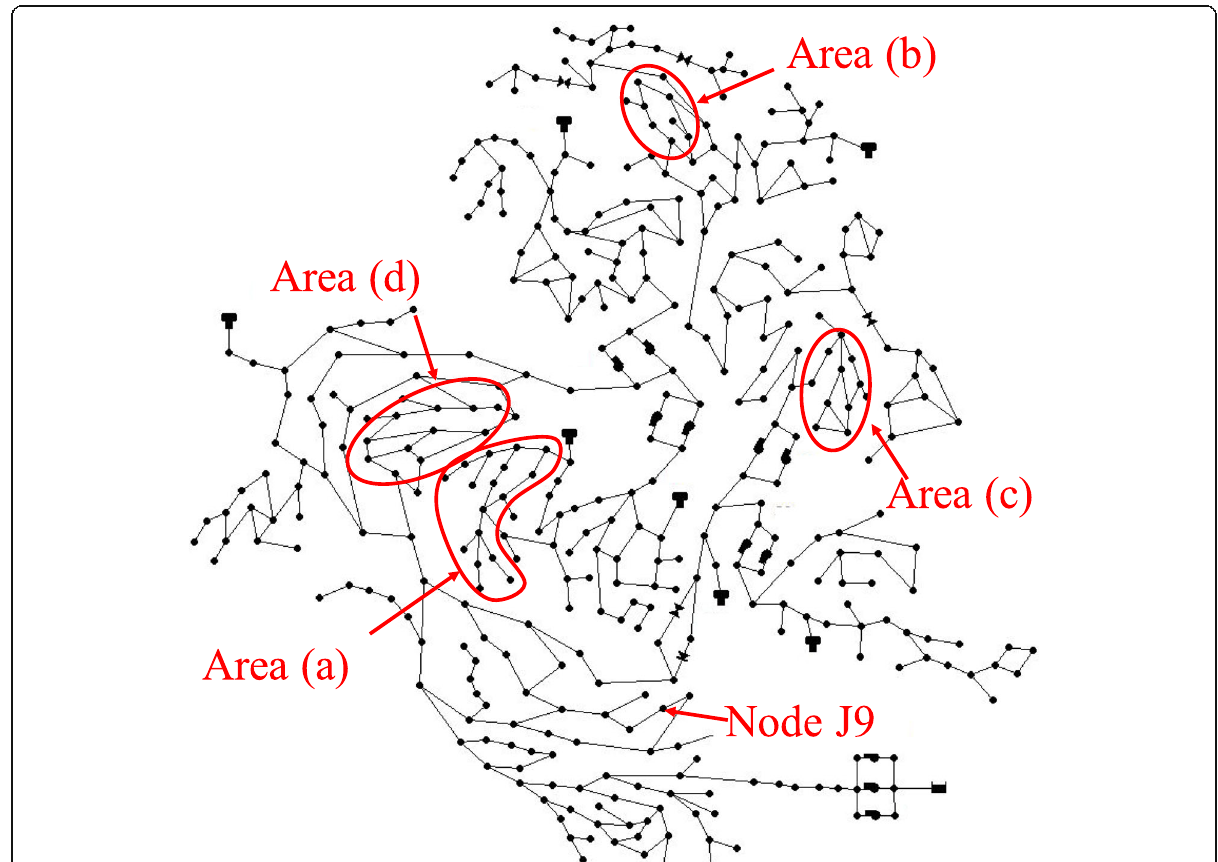
Fig. 17 Topology of the C-Town WSN with DMA areas